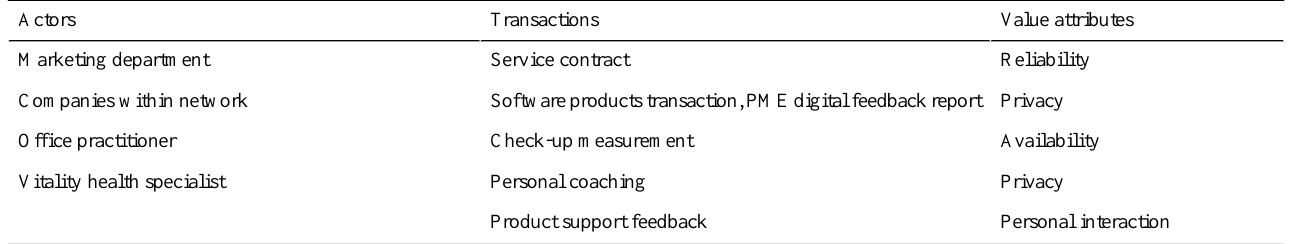
Table 4. Network coordinator’s overview of actors, transactions, and value